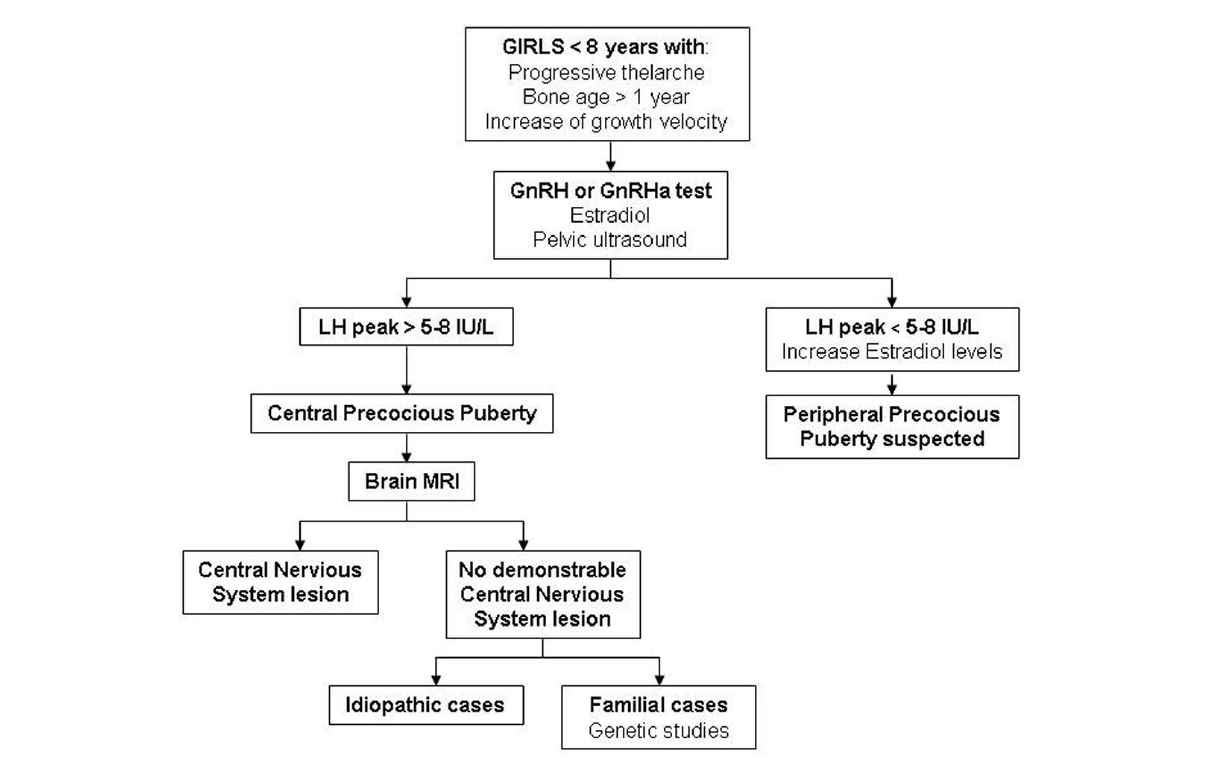
Figure 1 : Diagnostic algorithm of CPP in